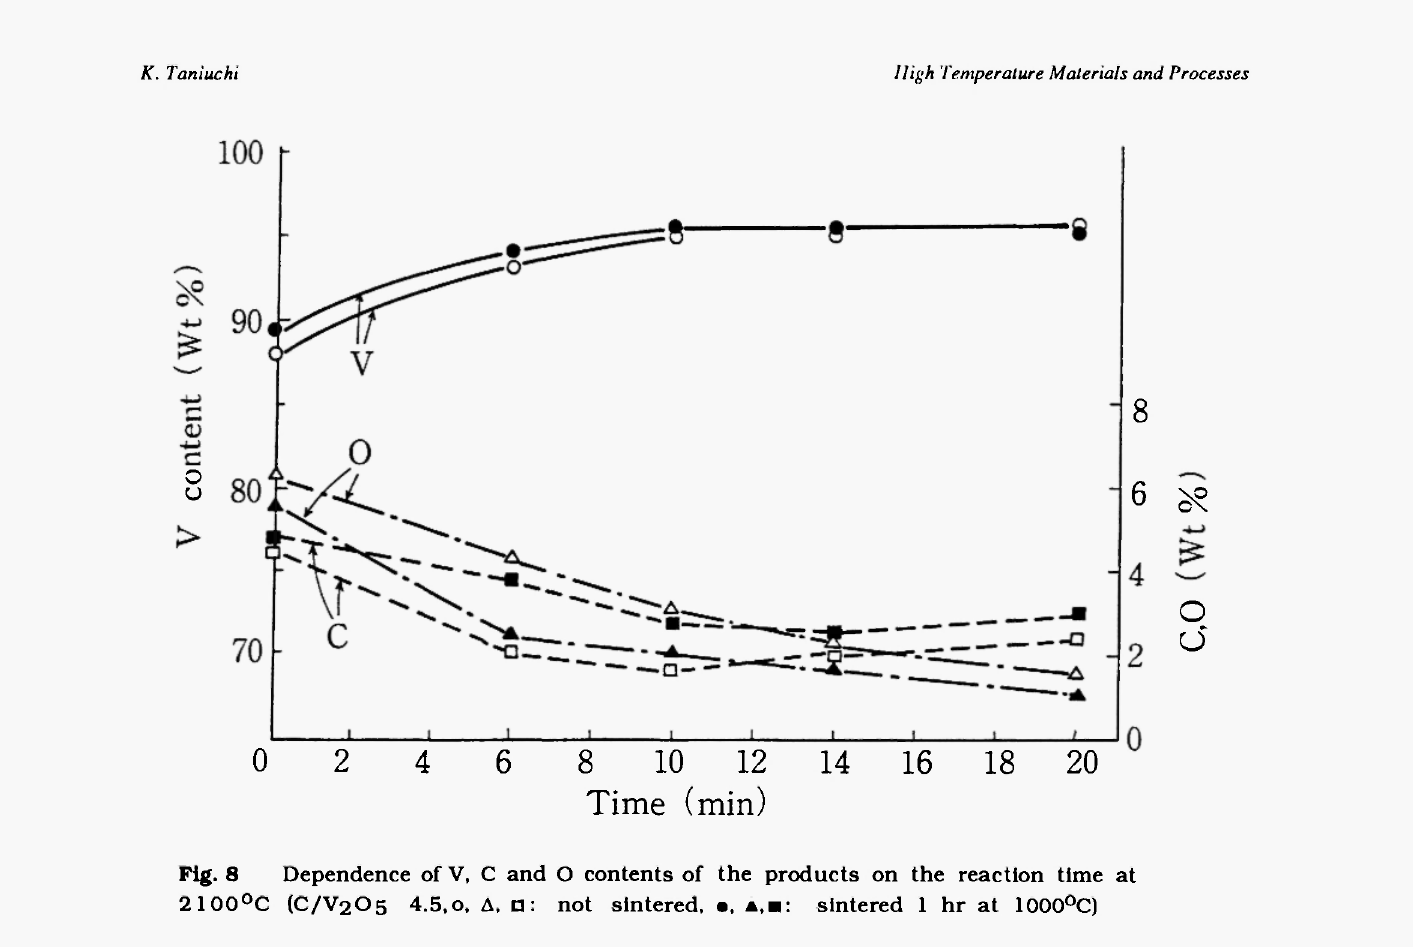
Fig. 8 Dependence of V, C and Ο contents of the products on the reaction time at 2 1 0 0 °C 4.5,o, Δ, a: not sintered, ·.